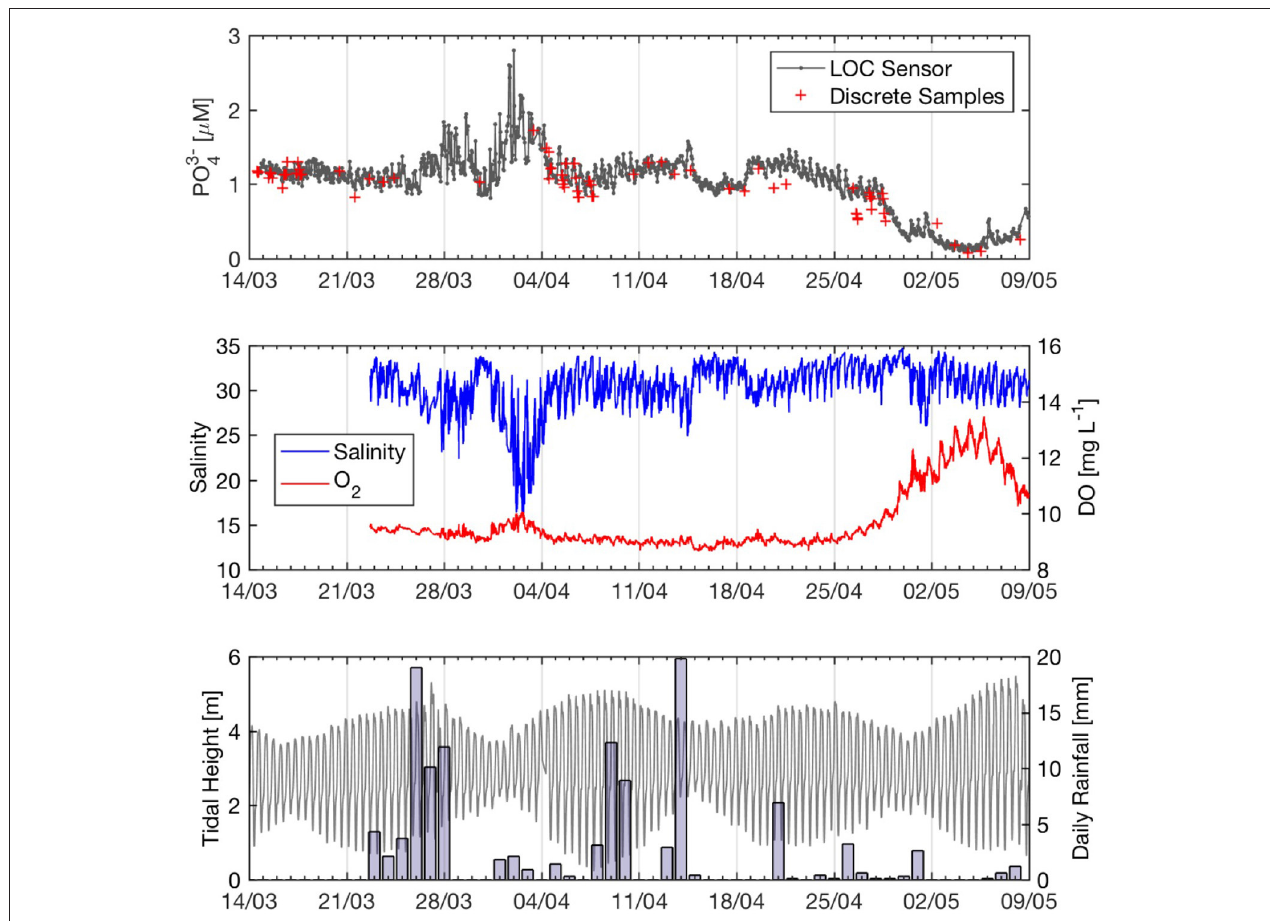
FIGURE 8 | Fifty-six-day time series of phosphate and environmental parameters at Empress Dock, Southampton Water in Spring 2016. (Top) Hourly phosphate sensor data ( n = 1,267) and discrete samples ( n = 61). (Middle) YSI Salinity and oxygen (5min sampling frequency). (Bottom) Tide data from SOTONMET (Associated British Ports) and daily rainfall in Southampton City (bars). Rain data from